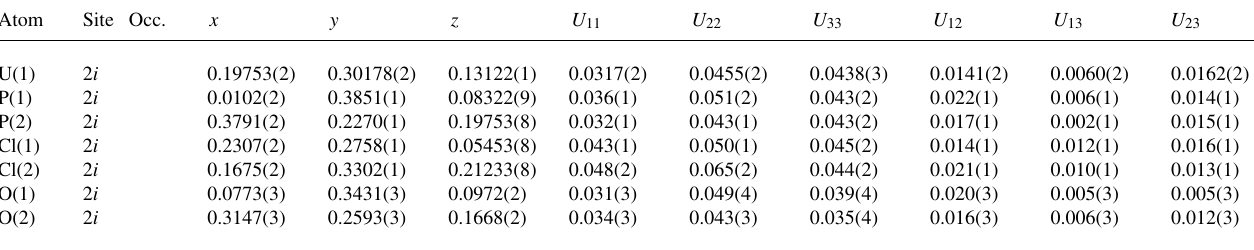
Table 3. Atomic coordinates and displacement parameters (in Å 2 ) . Atom Site